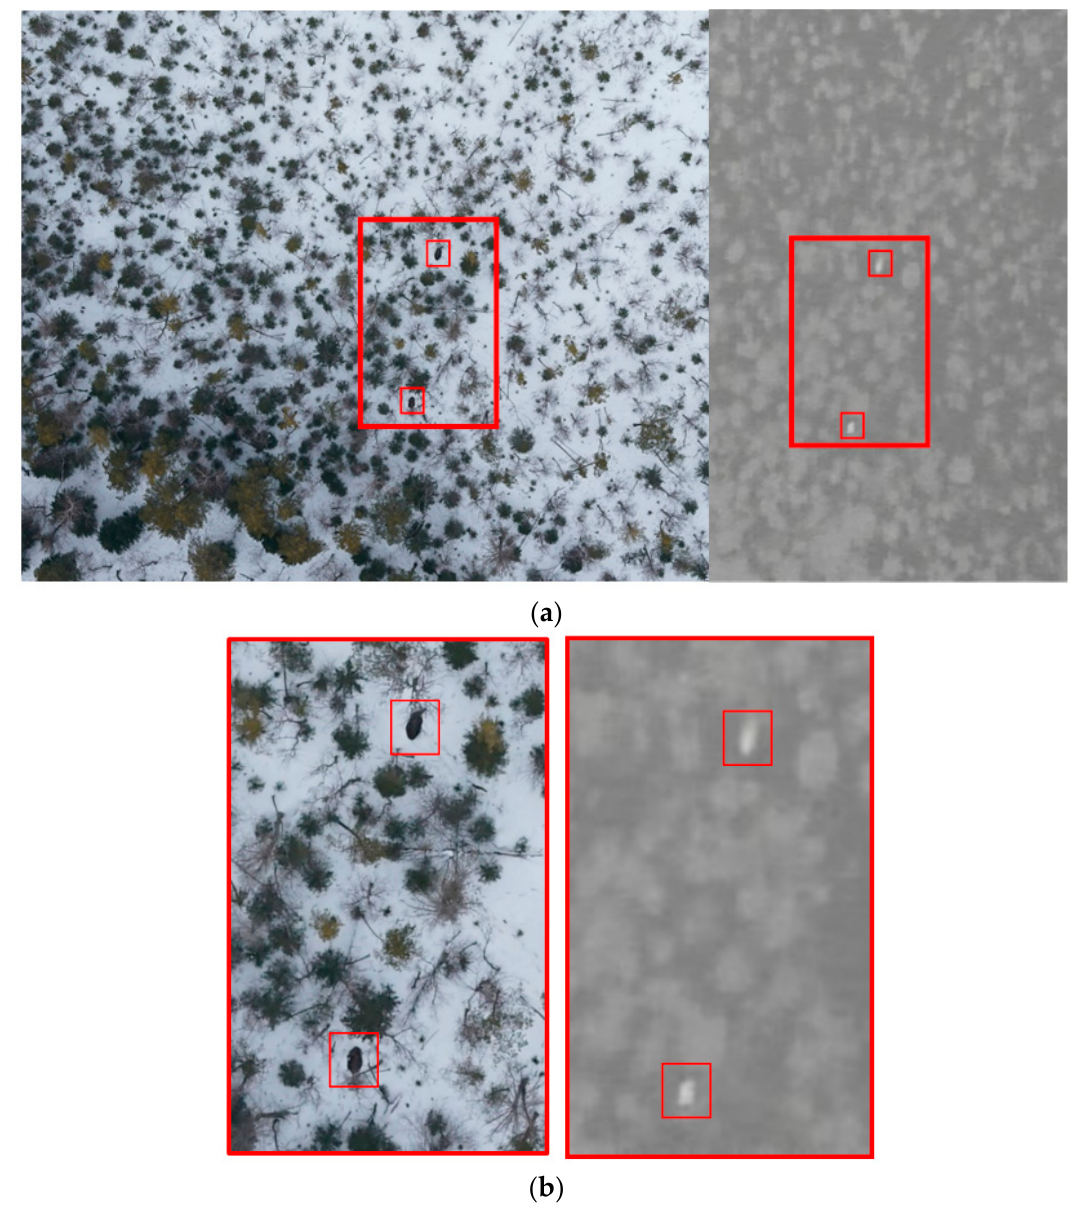
Figure 2. RGB vs. infrared images at ( a ) low and ( b ) high resolution.